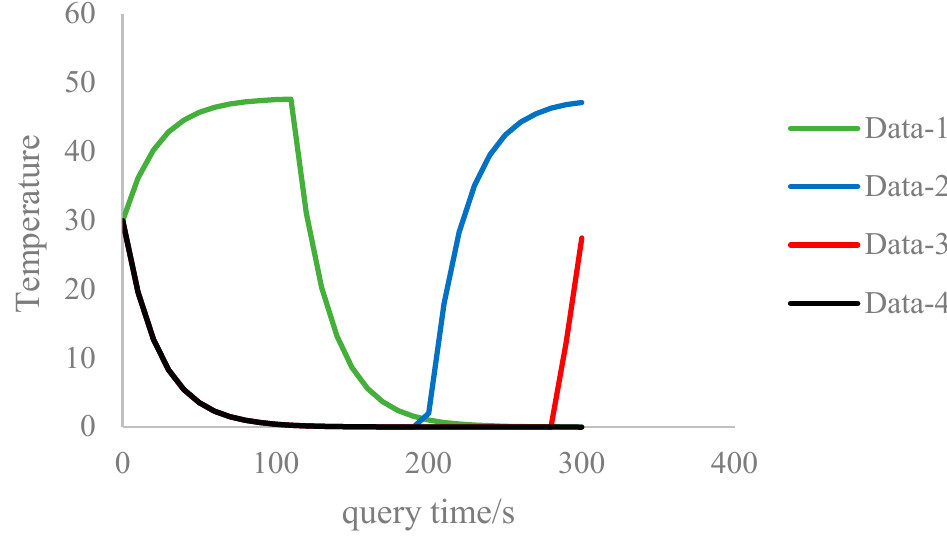
Figure 7. Influence of access time on temperature in S-TCR method.